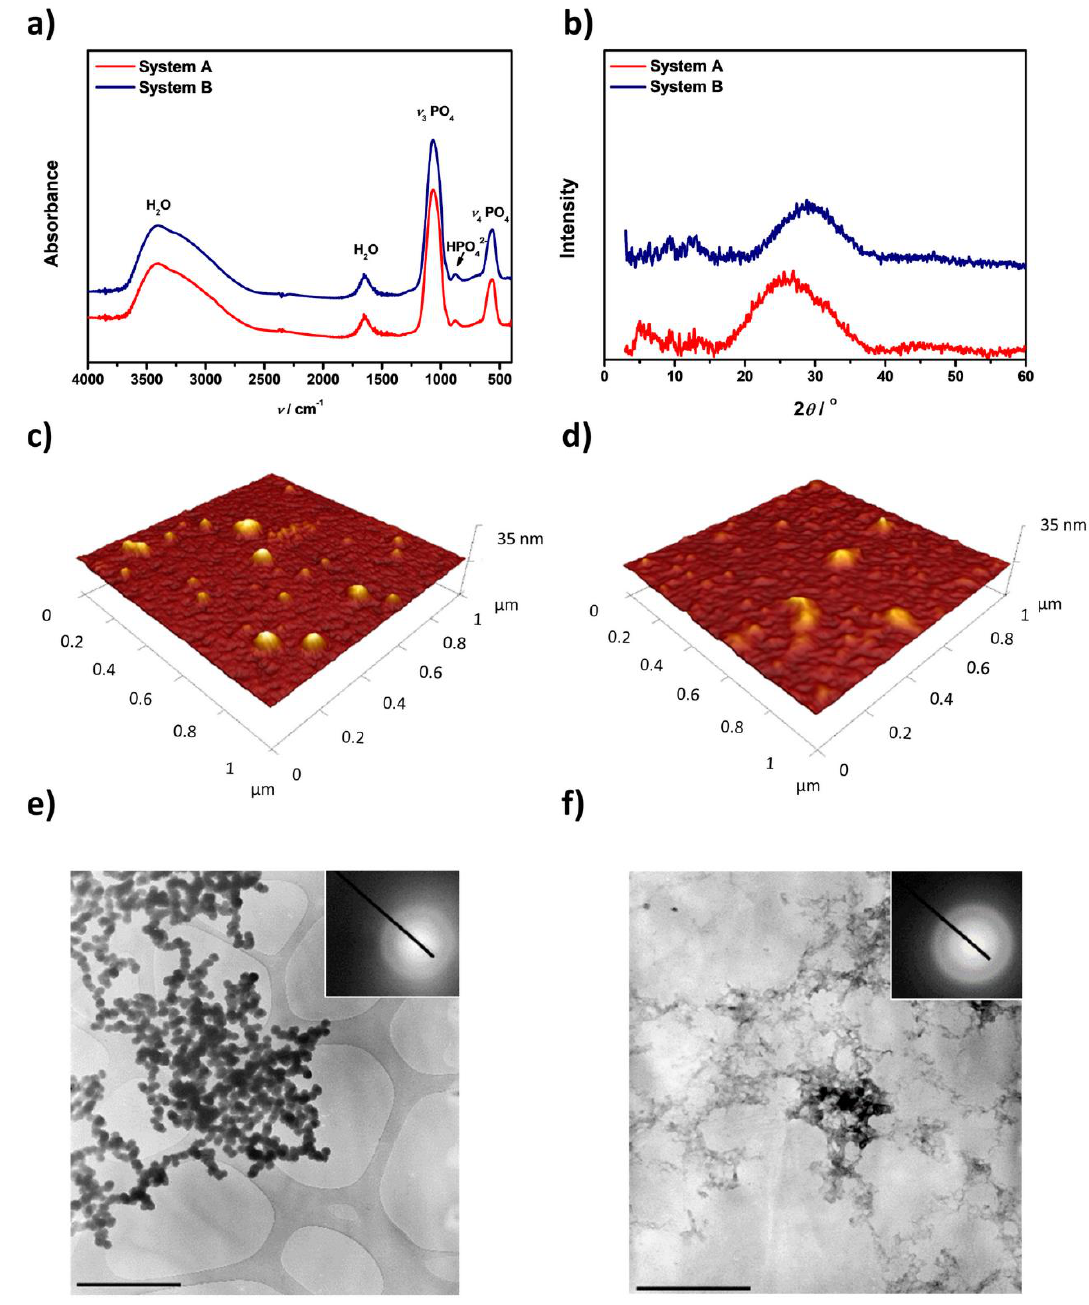
Figure 2. ( a ) Fourier Transform Infrared Spectroscopy (FTIR) spectra, ( b ) X-ray Diffraction Figure 2. a) Fourier Transform Infrared Spectroscopy (FTIR) spectra, b) X-ray Diffraction (XRD)